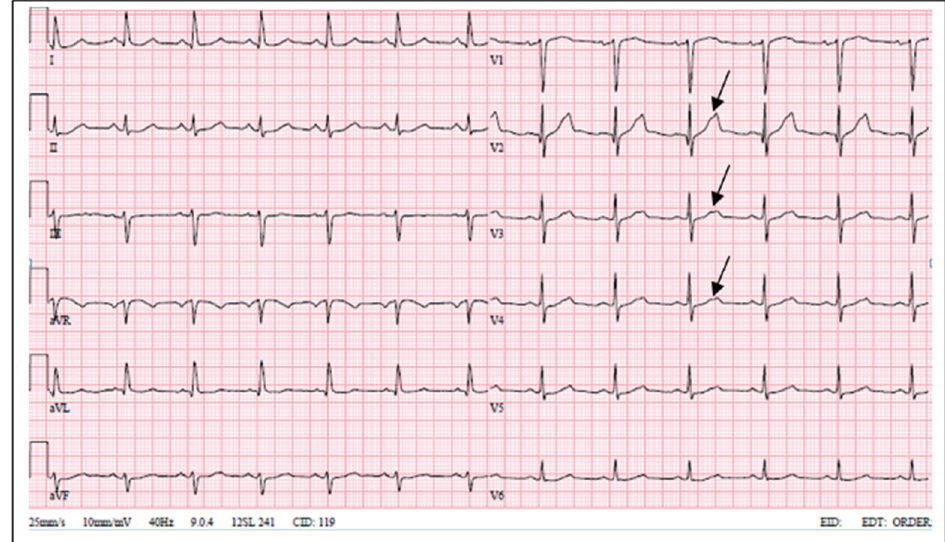
Figure 3. Patient’s mother ECG (notched T waves, QTc 489 ms).